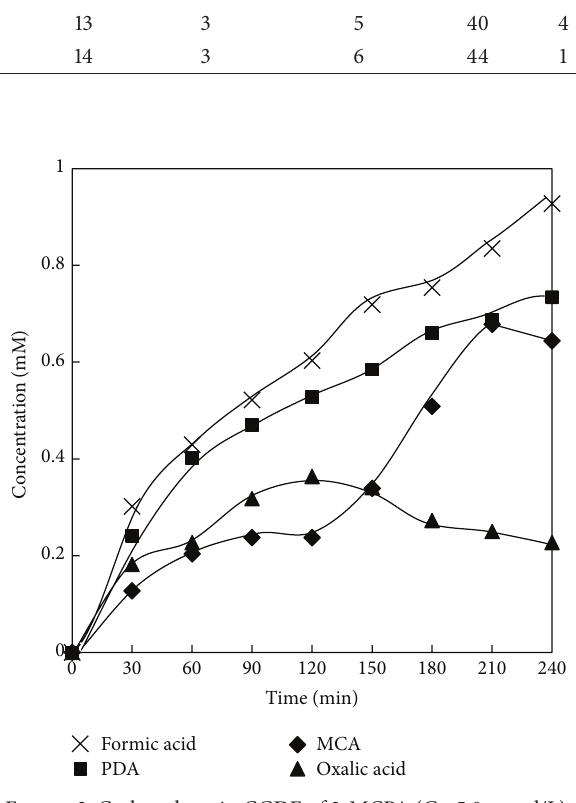
Figure 3: Carboxylates in CGDE of 3-MCPA ( 𝐶 0 : 5.0